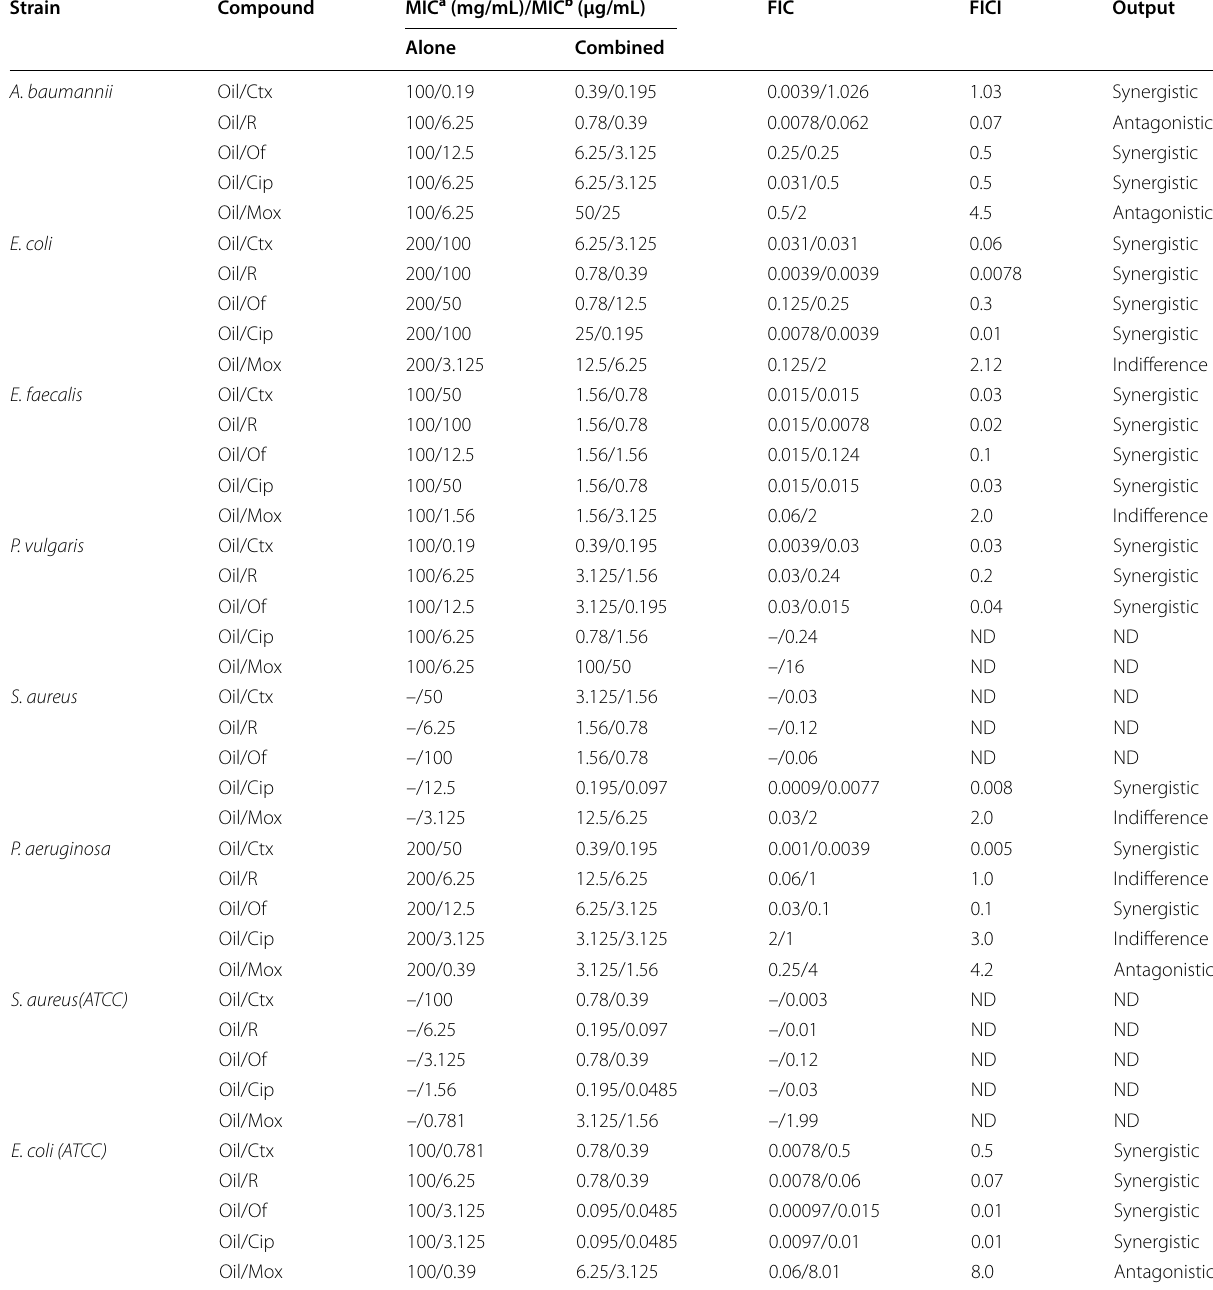
MIC a minimal inhibitory concentration for seed oil when applied alone, MIC b minimal inhibitory concentration for antibiotic when applied alone, Me methanolic extract, Ctx cefotaxime, R rifampicin, Of ofloxacin, Cip ciprofloxacin, Mox moxifloxacin, ND not determined